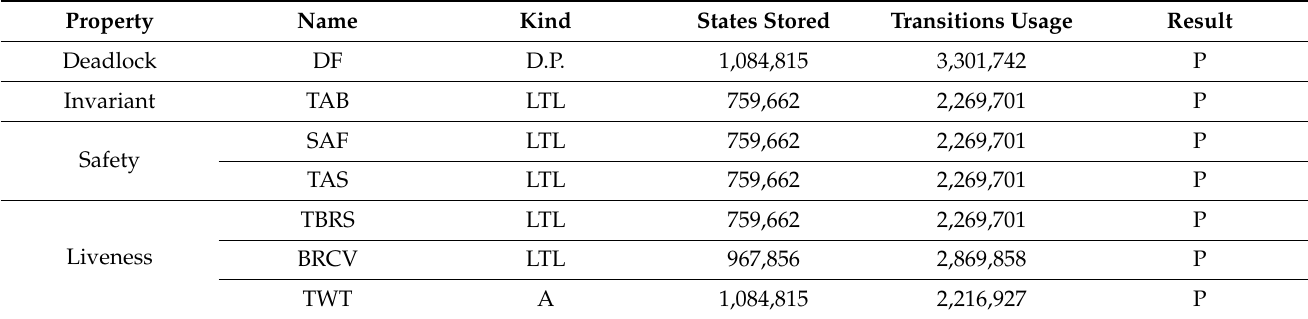
Table 1. The result of